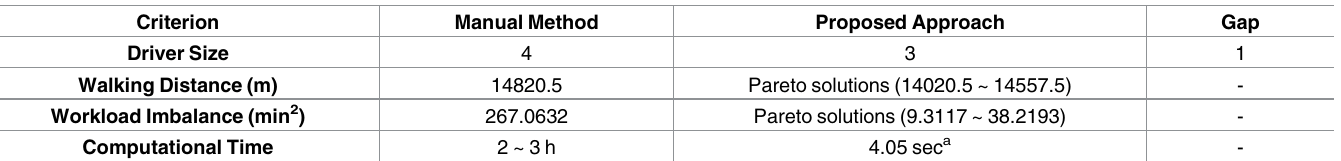
Table 3. Comparisons between the manual method and proposed